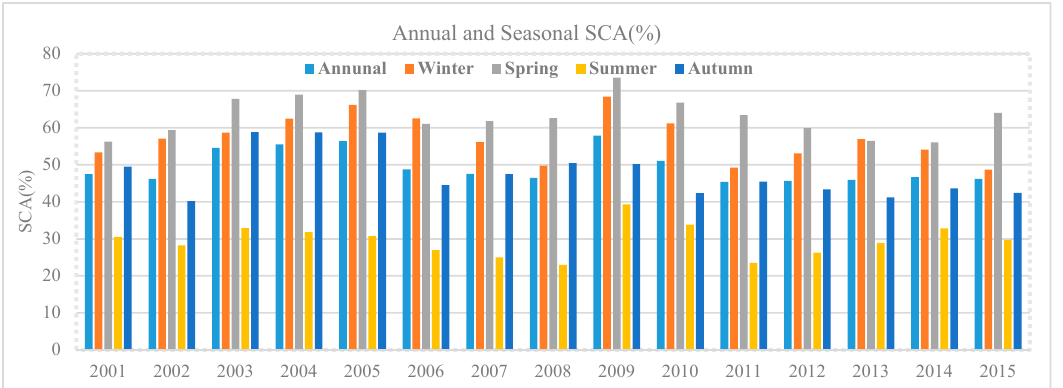
Figure 5. Annual and Seasonal mean SCA (%) for the period 2001–2015.